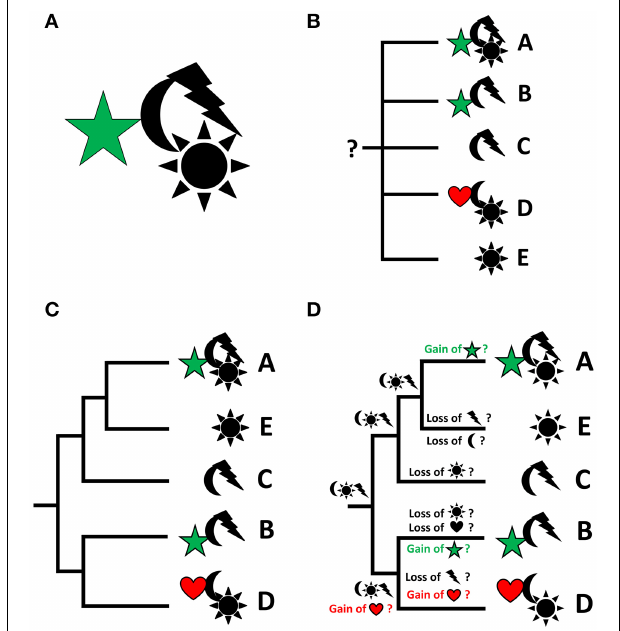
FIGURE 1 | From descriptive science to reconstruction of character evolution by integrating descriptive data and phylogeny. Characters or character states are represented by symbols, taxa by letters. Particular focus is on the evolution of the characters “star” and “heart,” which are therefore depicted in color. (A) Every organism (or taxon) is an assemblage of (known and unknown) characters in specified character states. (B) Describing characters of given taxa is a prerequisite of phylogenetic analyses, but the characters by themselves do not produce a phylogenetic scenario and do thus not allow for ancestral character reconstruction (indicated by the question mark). (C) A phylogenetic analysis results in a hypothesis as to how given (groups of) organisms may be related to each other. (D) The resulting phylogeny allows to project the individual characters of interest onto the phylogenetic tree in order to infer their potential evolutionary emergence, loss, or transformation (usually using the parsimony approach). Thus, potentially, for any given monophyletic unit, a character set of the last common ancestor of the considered taxa can be reconstructed. Thereby, it is irrelevant whether or not the characters that are plotted onto the tree were part of the phylogenetic